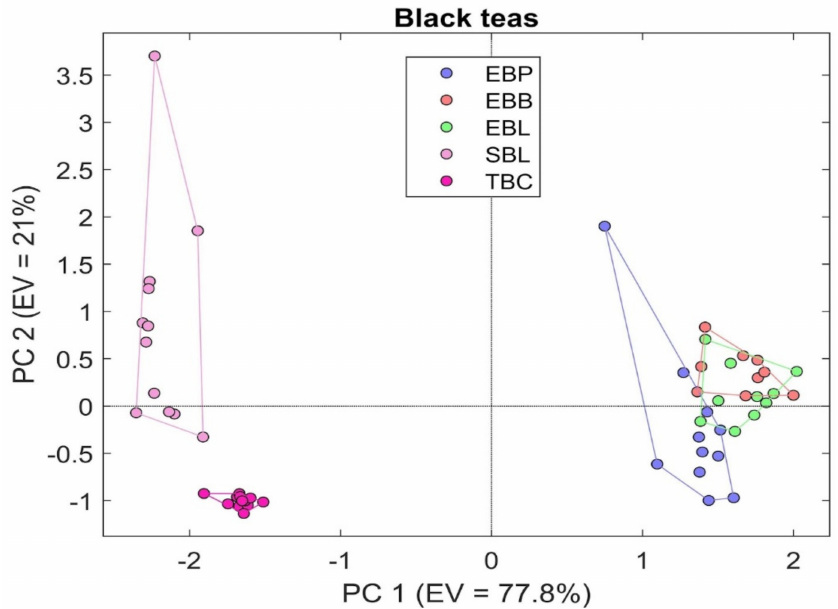
Figure 5. PCA analysis representing the results obtained from the comparison between black